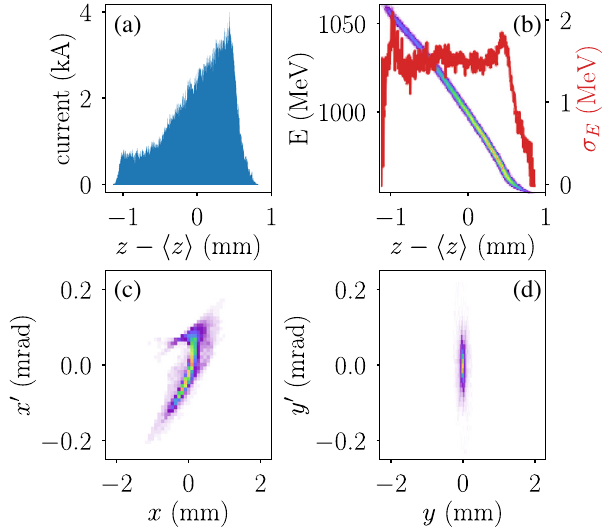
FIG. 14. Current (a) with associated LPS (b), and transverse horizontal (c) and vertical (d) phase-space distributions simulated with ELEGANT at the end of BC2 using the optimized linac and bunch-compressor settings summarized in Table IV and the injector distributions from Fig. 13. In plot (b) the red trace represents the slice rms energy spread σ . E